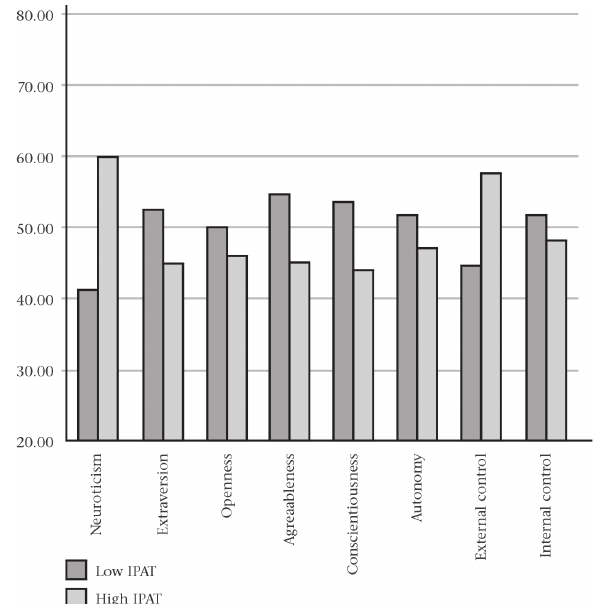
Figure 3: Personality profile of participants who are high on anxiety and those who are low on